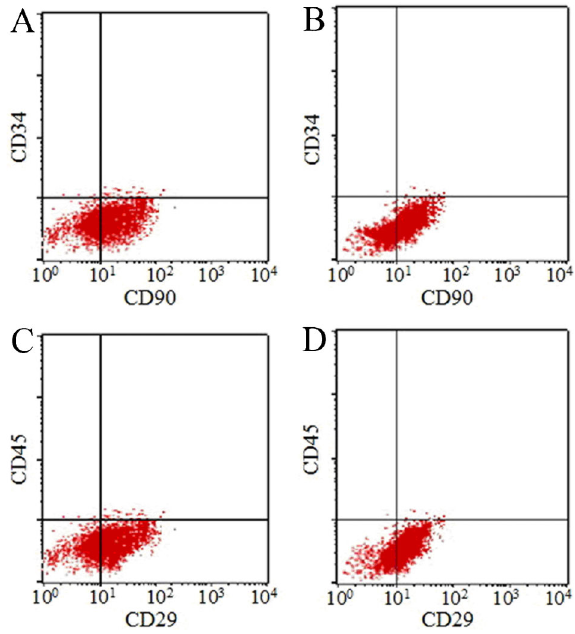
Figure 2. Immune-phenotypic analysis through flow cytometry detection. A , C , myelodysplastic syndromes (MDS) group; B , D , normal control group.